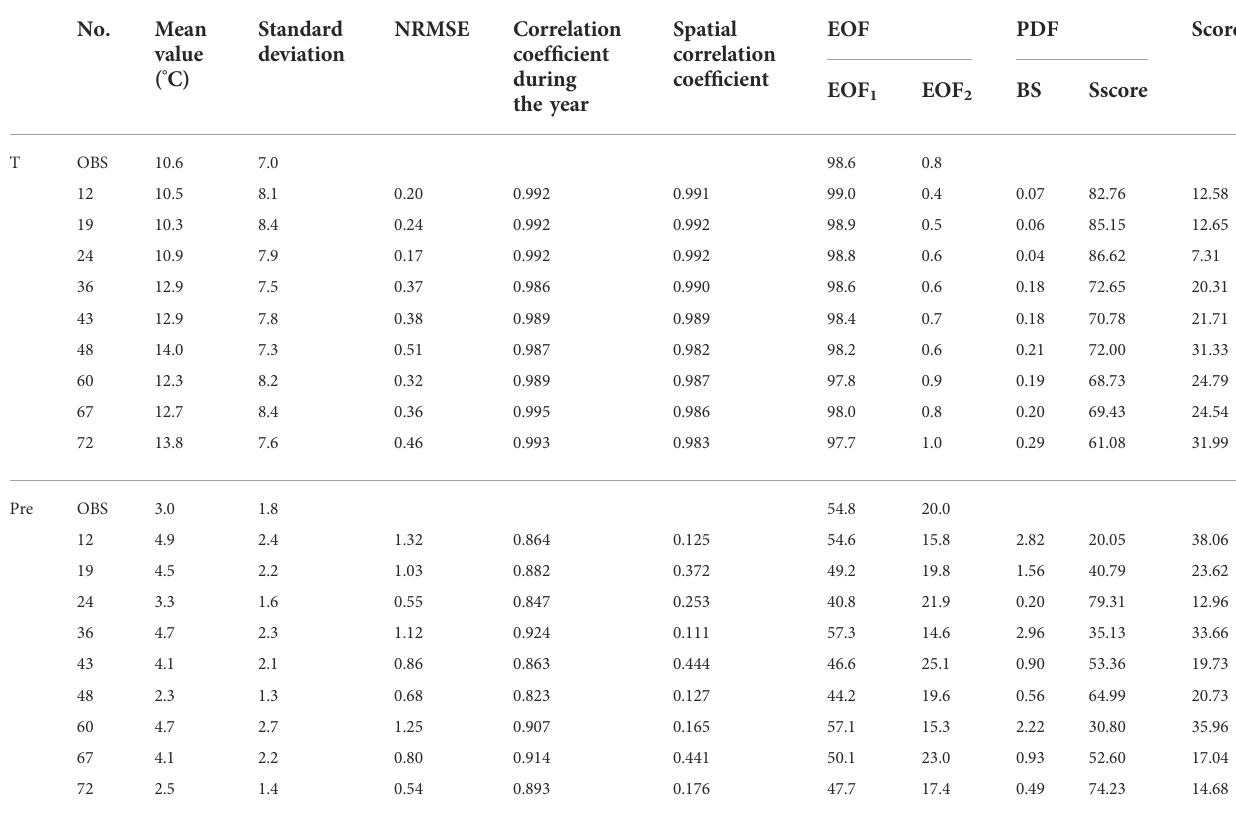
TABLE 4 Evaluation results for air temperature in China and the UYRB in nine